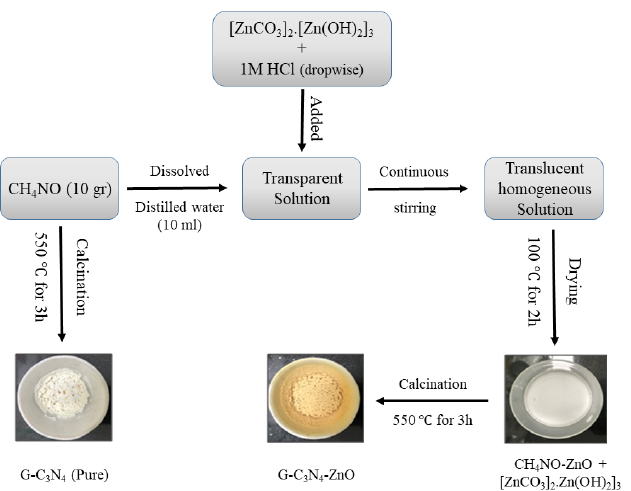
Figure 12. Schematic of the g-C 3 N 4 −ZnO heterojunction synthesis approach, reproduced from Reference [158].